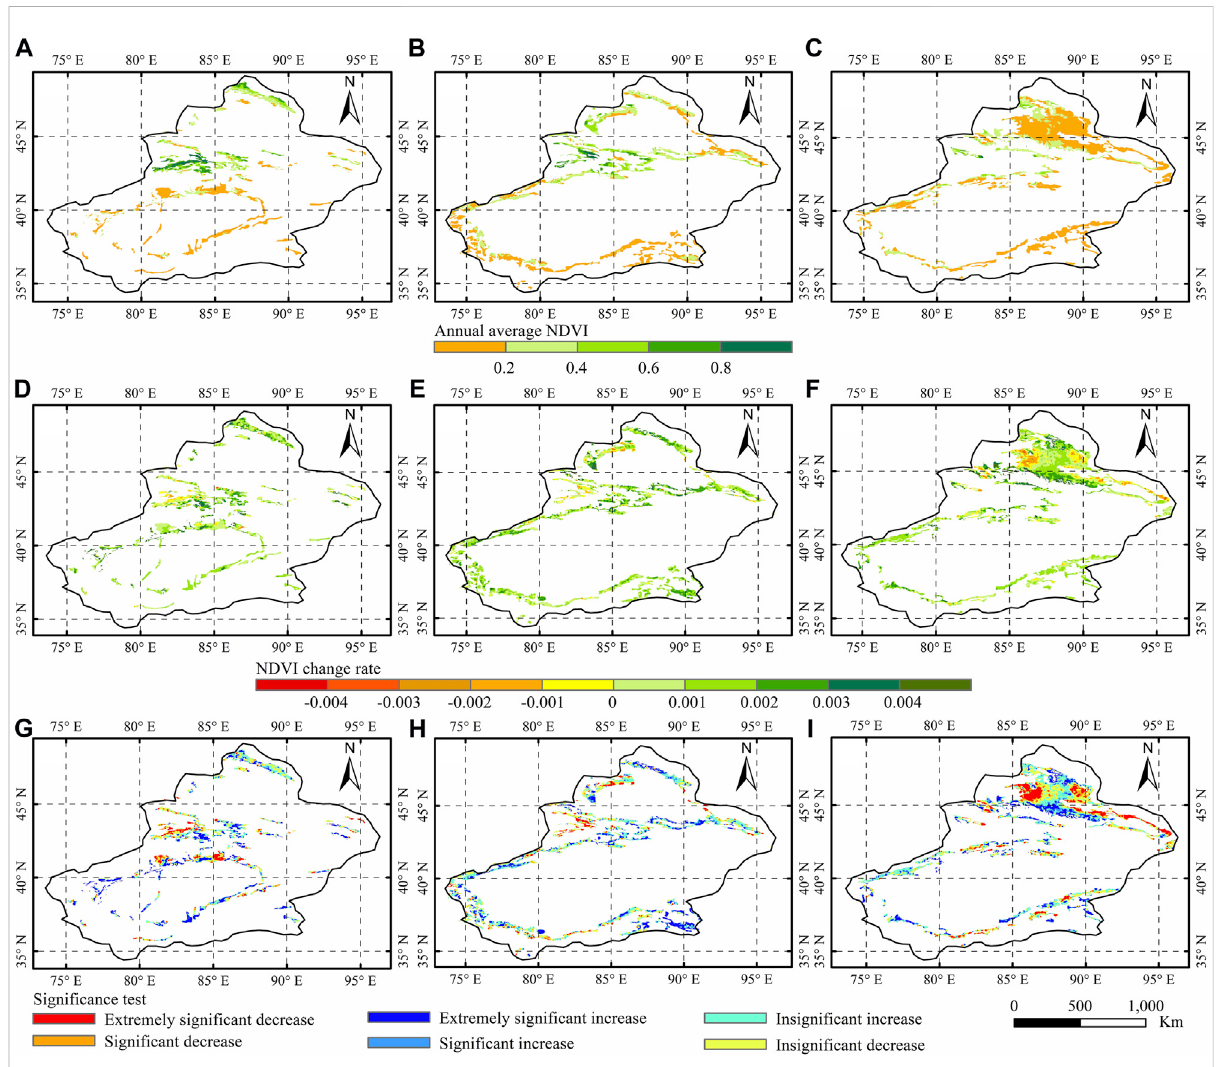
FIGURE 3 Spatial distribution pattern of the annual average NDVI and change rate and signi fi cance test of meadow, steppe, and desert grassland in Xinjiang. [Annual average NDVI of meadow (A) , steppe (B) , and desert grassland (C) in Xinjiang; the NDVI change rate of meadow (D) , steppe (E ), and desert grassland (F) in Xinjiang; and the signi fi cance test of meadow (G) , steppe (H) , and desert grassland (I) in